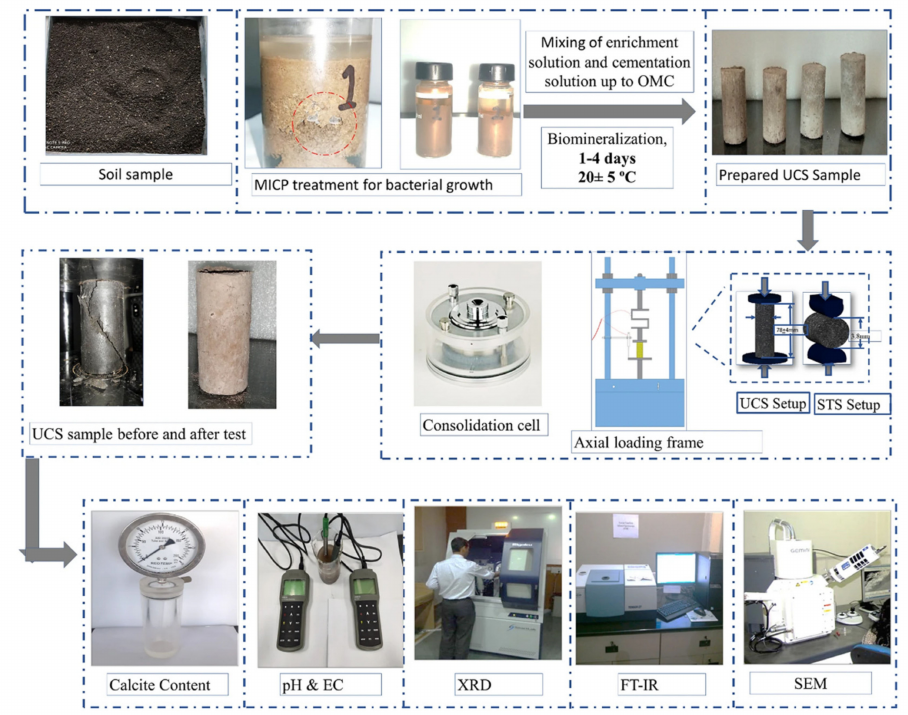
Figure 9. Detailed treatment procedures and testing procedures for microbial solidified sand